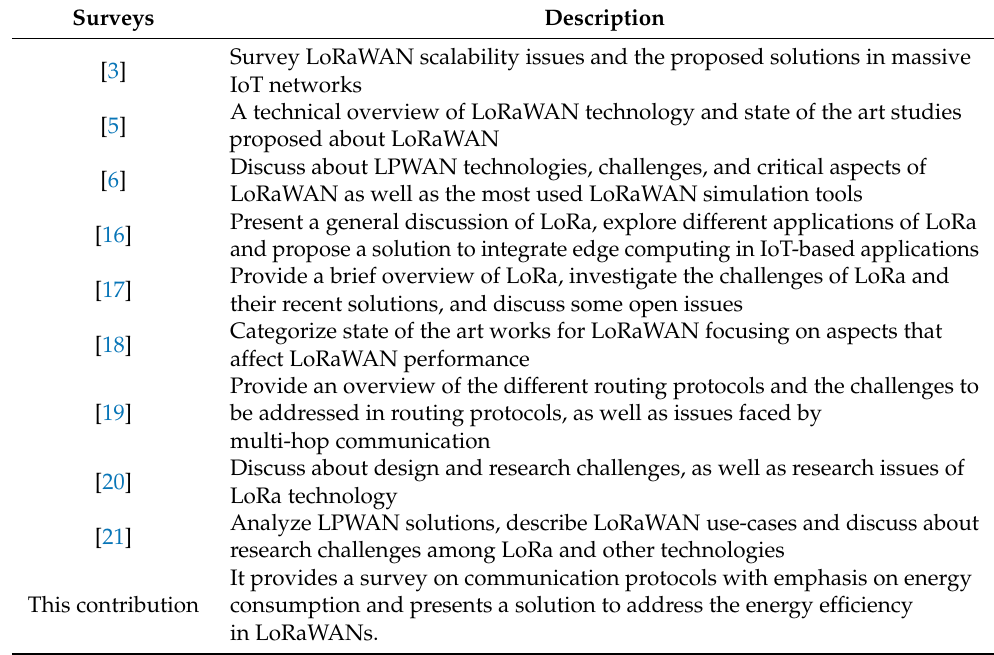
Table 1. Summary of state-of-the-art surveys on LoRaWAN.